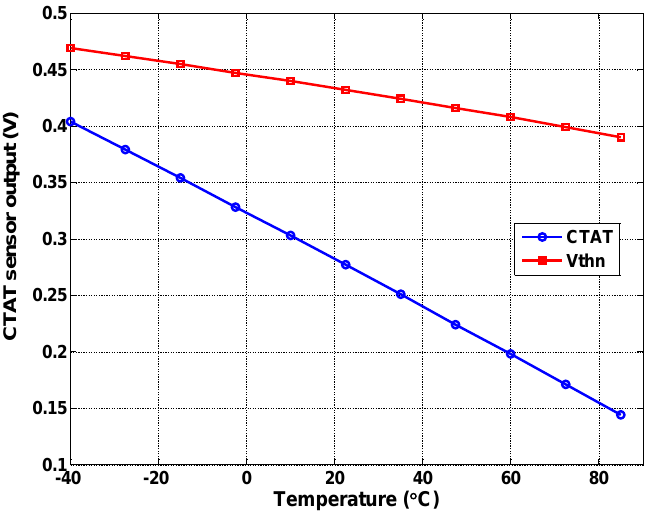
Figure 4. Simulation result of CTAT output V N and threshold voltage V thn with temperature. Thermal slopes of V thn and V N are − 0.63 mV/ ◦ C and − 2.1 mV/ ◦ C,